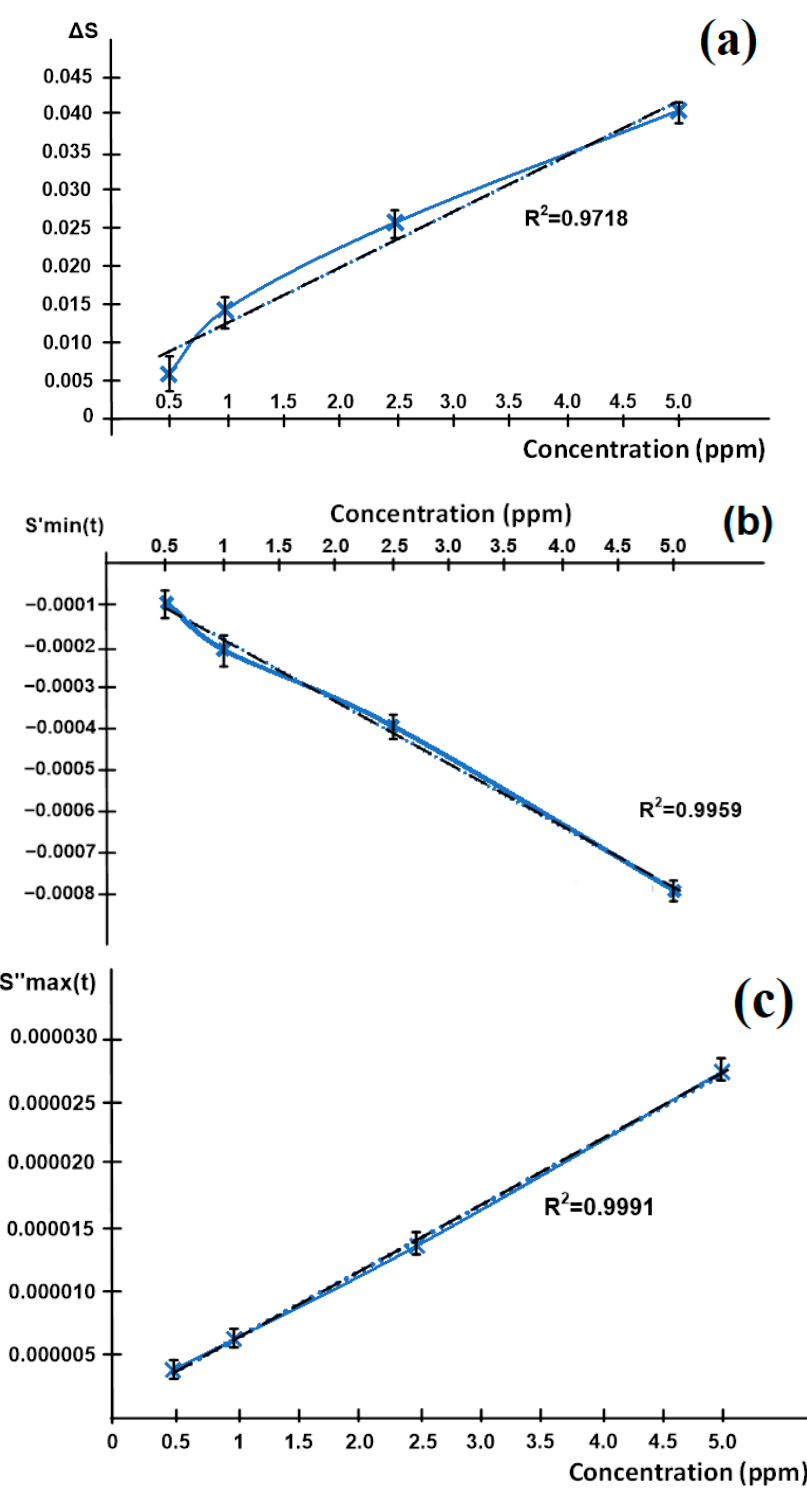
Figure 7. Calibration curves for NO 2 concentration estimation of the Type 2 sensor: ( a ) of the adsorption response Δ S at the saturation moment; ( b ) minimum of the first derivative S ′ ( t ); ( c ) maximum of the second derivative S ″ ( t ).